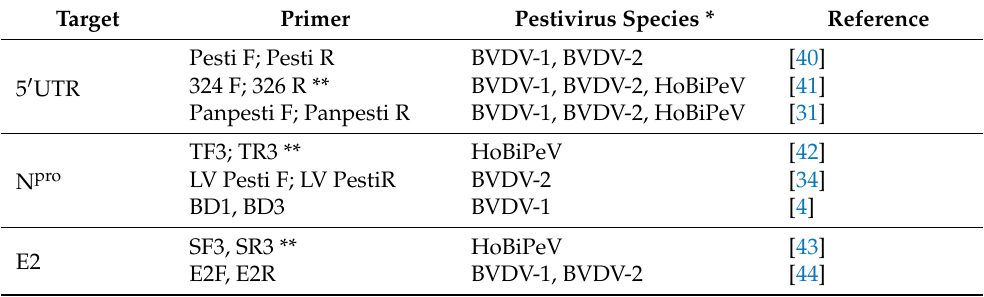
Table 1. Description of the primers used for RT–PCR targeting the pestivirus 5 (cid:48) UTR, N pro , and E2. Target